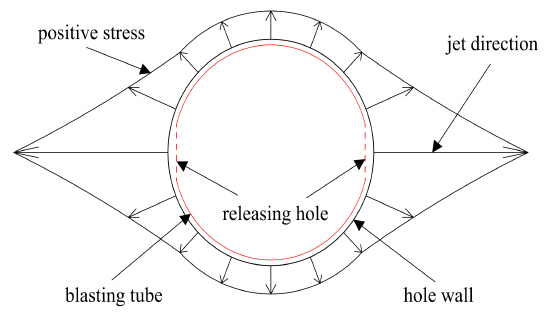
Figure 14. Schematic diagram of the initial stresses on the blast hole wall.